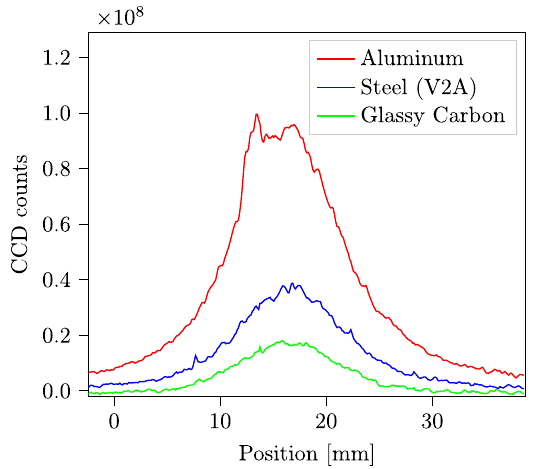
FIG. 8. Individual image taken with an 80 - μ s gate for 200 μ A Bi 26 þ beam current. The rectangle marked on the top left is used to subtract the background counts per